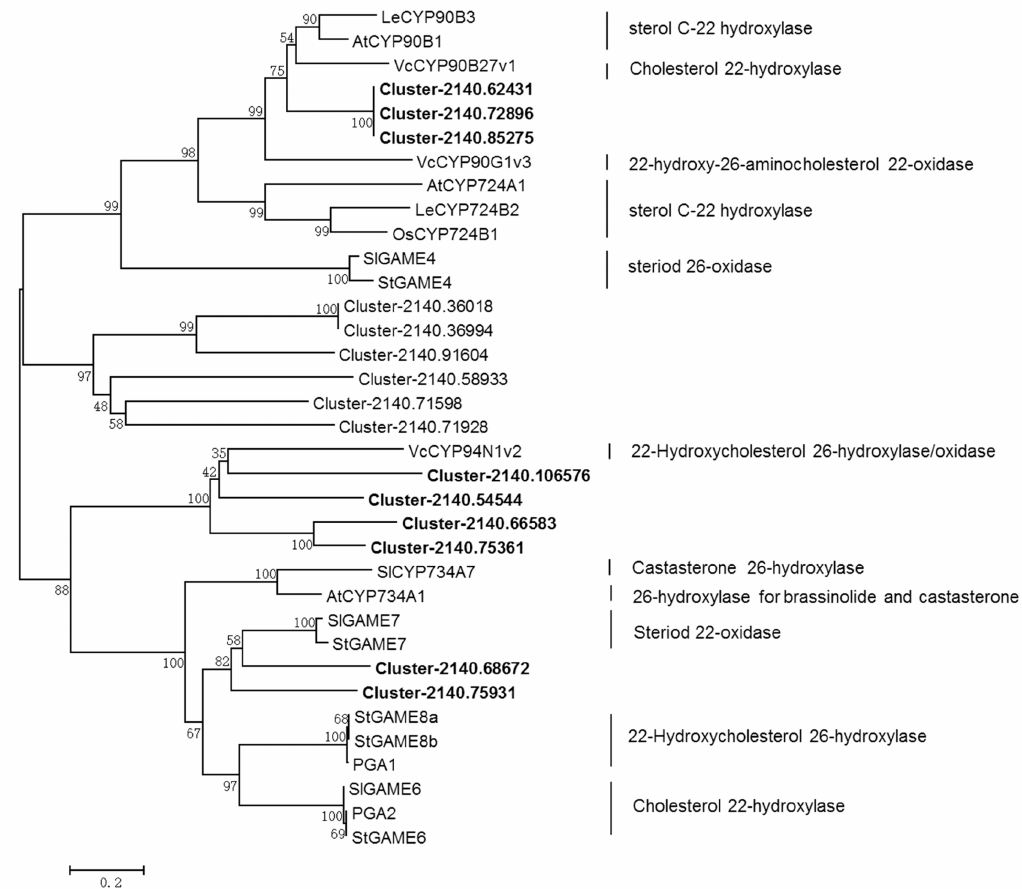
Figure 4. Phylogenetic tree analysis of the 15 MeJA-upregulated T. foenum-graecum CYP450 candidates with known steroid oxidizing CYP450s.